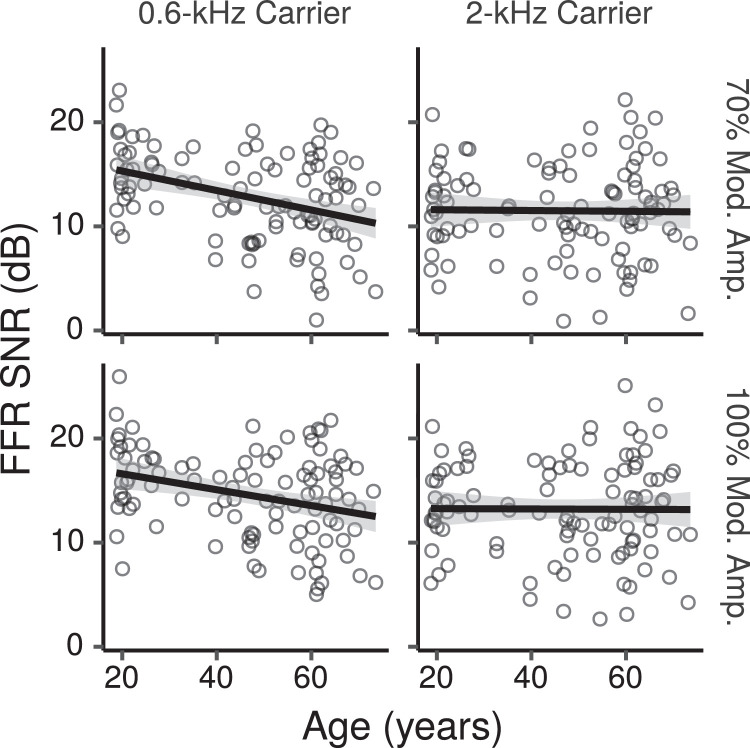
Across-montage average FFR ENV SNR by age. Each panel shows a least squares line fit of FFR SNR by age with 95% confidence intervals as a visual aid. The slope for the effect of age estimated by the Bayesian multiple regression model is not the same as that shown in the figure.